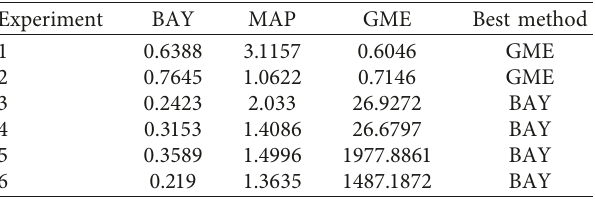
Table 3: Mean squares error for the Weibull growth model.